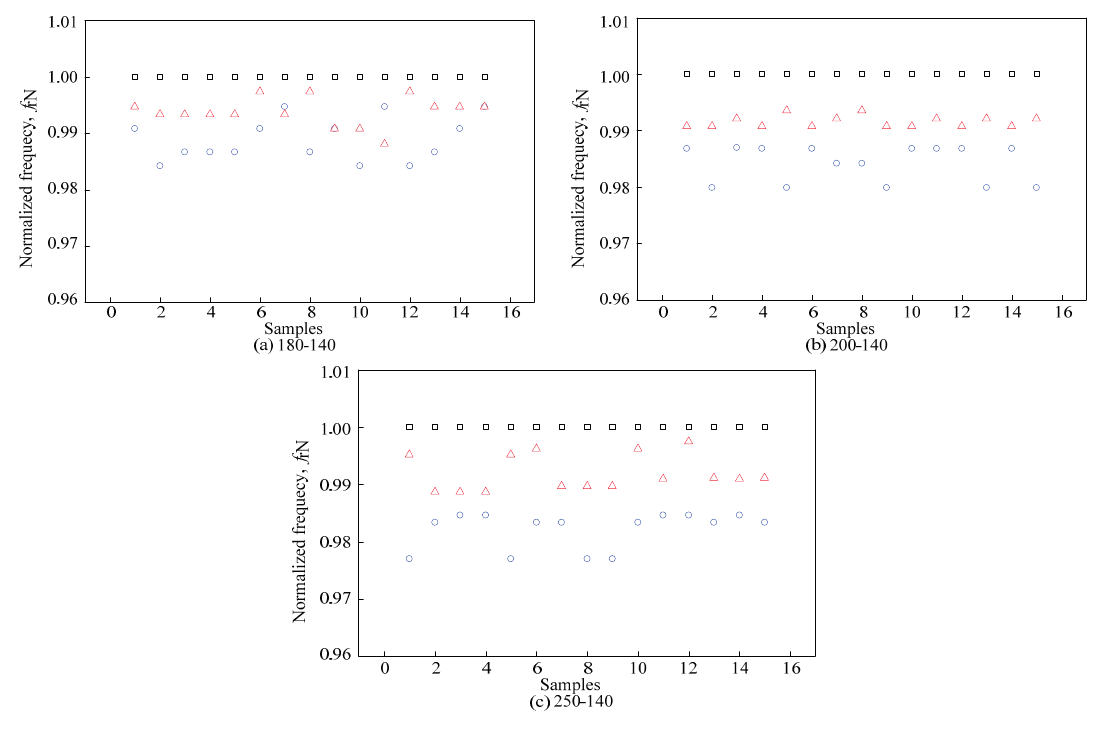
Figure 11. Normalized resonant frequency of the second peak for each coil’s turns configuration: □ air ∆ ripe ○